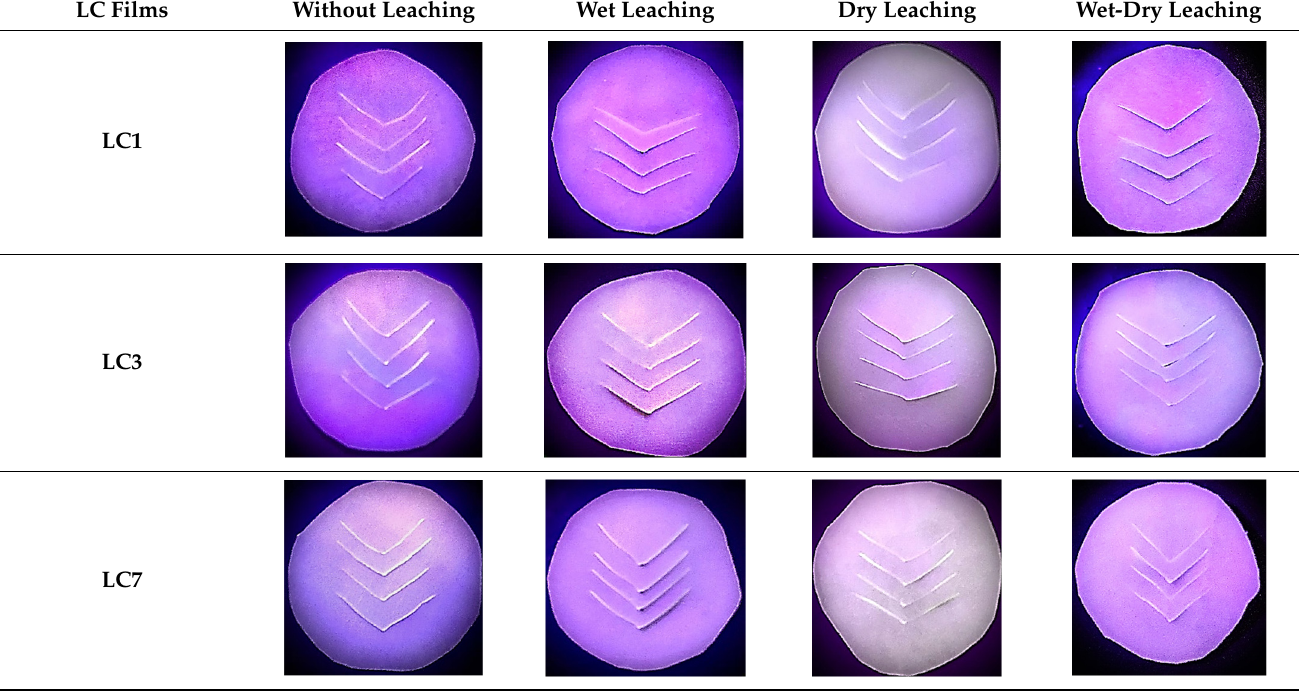
Table 4. Images of LC1, LC3, and LC7 torn film before and after